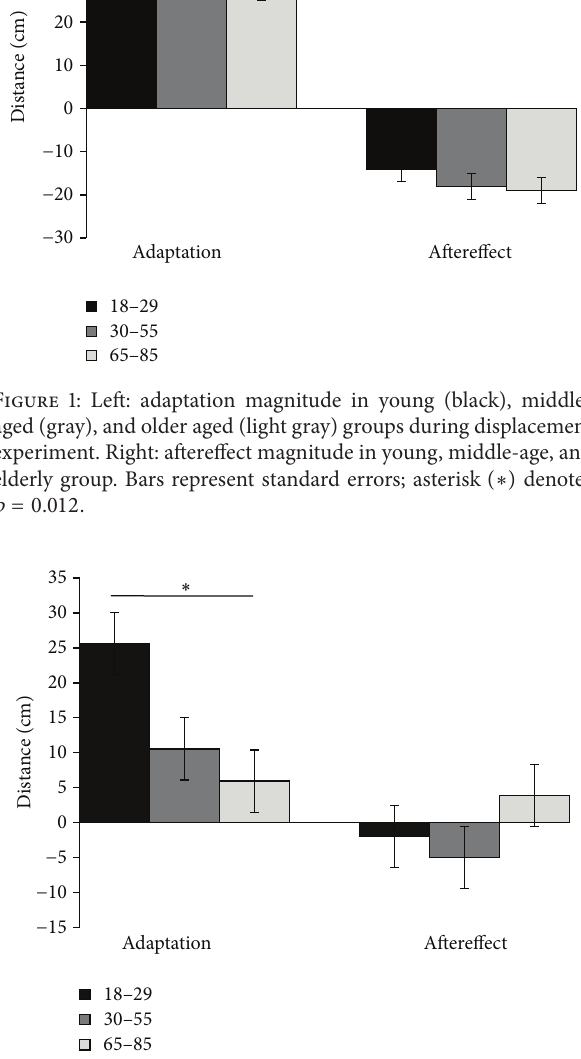
Figure 2: Left: adaptation magnitude in young (black), middle- aged (gray), and older aged (light gray) groups during reversal experiment. Right: aftereffect magnitude in young, middle-age, and elderly group. Bars represent standard errors; asterisk (∗) denotes 𝑝 = 0.024